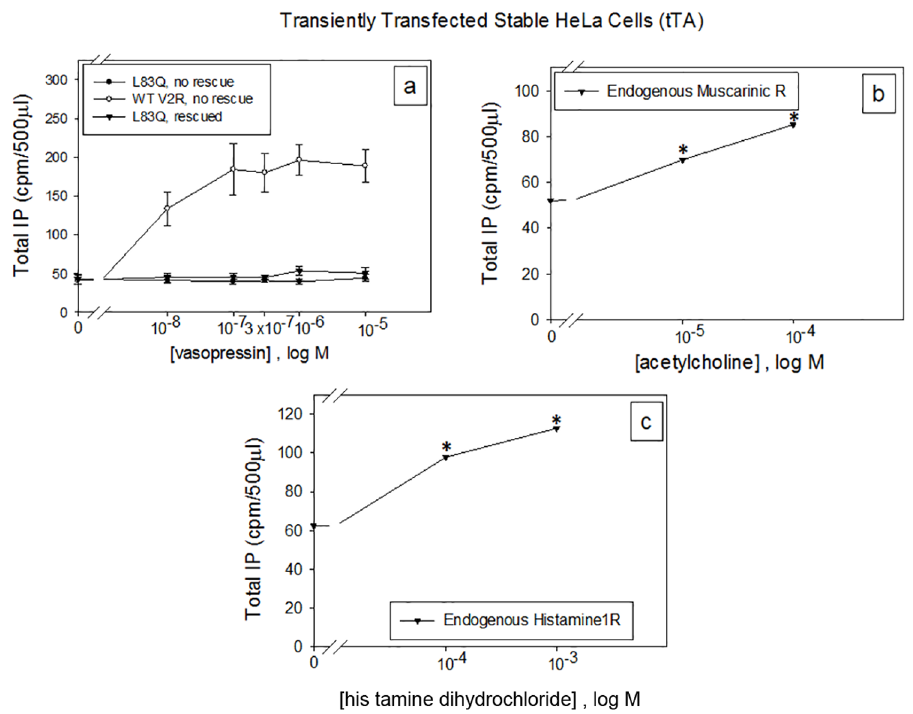
Fig 2. IP production following transient transfection of HeLa cells for selected GPCRs and V2R mutants. Transientlytransfected HeLa cells containing a total of 100 ng cDNA/ 0.125 ml of hWT V2R or the mutant hL83Q were used to compareGq (IP) couplingwith the vasopressinreceptor, endogenousmuscarinic M3 subtype and histamineH1 receptors with or without 10 μ M SR121463B pharmacoperone(rescues the L83Q mutant), DMSO (vehicle) is a negativecontrol. Cells were stimulatedwith various doses of vasopressin for 2 h, acetylcholineand histaminedihydrochloride for 30 minutes. The results shown in the figure are from at least 3 independentexperiments performed in quadruplicate(n = 3 ± SEM), p value < 0.05 is considered significant.